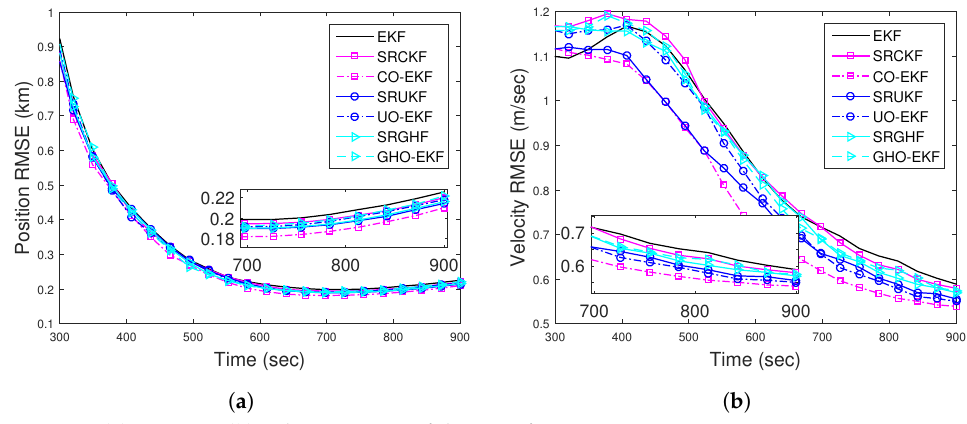
Figure 10. ( a ) Position; ( b ) velocity RMSE of the BOT for Scenario II.